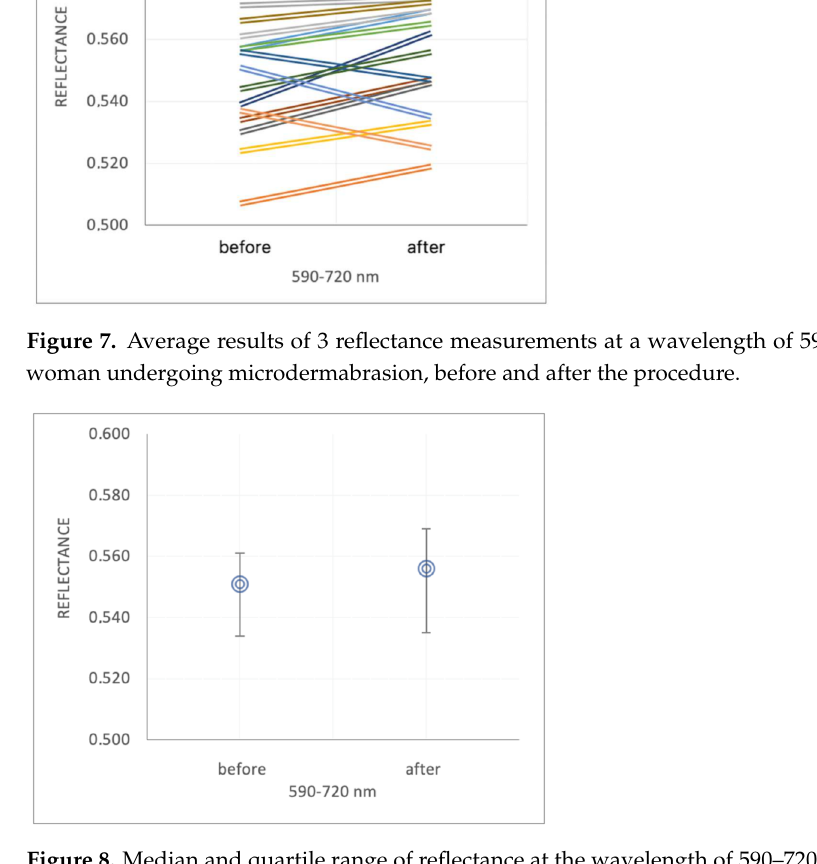
Figure 8. Median and quartile range of reflectance at the wavelength of 590–720 nm in the group of women undergoing microdermabrasion, before and after the